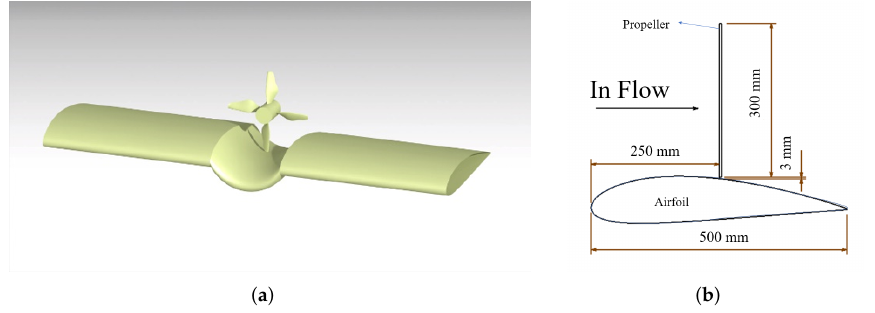
Figure 3. The model of the single-propeller channel wing integration. ( a ) Geometry of channel wing; ( b ) Section sketch at the wing symmetry plane.